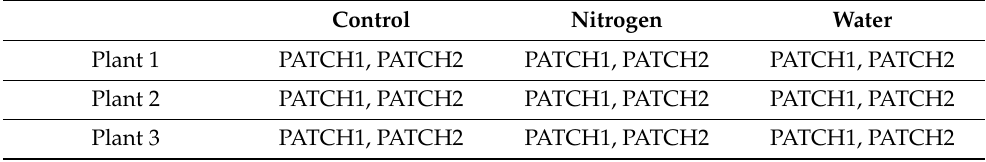
Table 2. Matrix of data of the patches that were developed in order to calculate the average re- flectance of plants in different leaf areas for the three different image locations in each of the three different